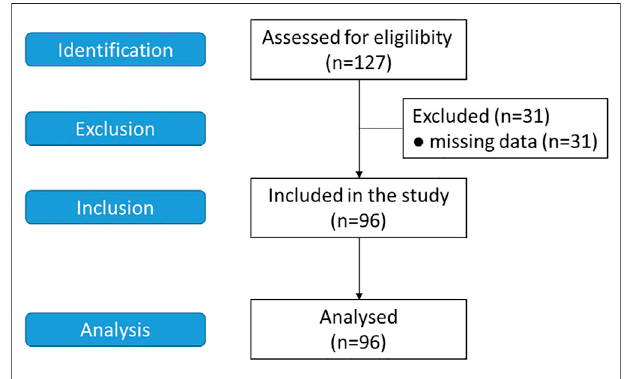
FIGURE 1 | Study fl owchart.